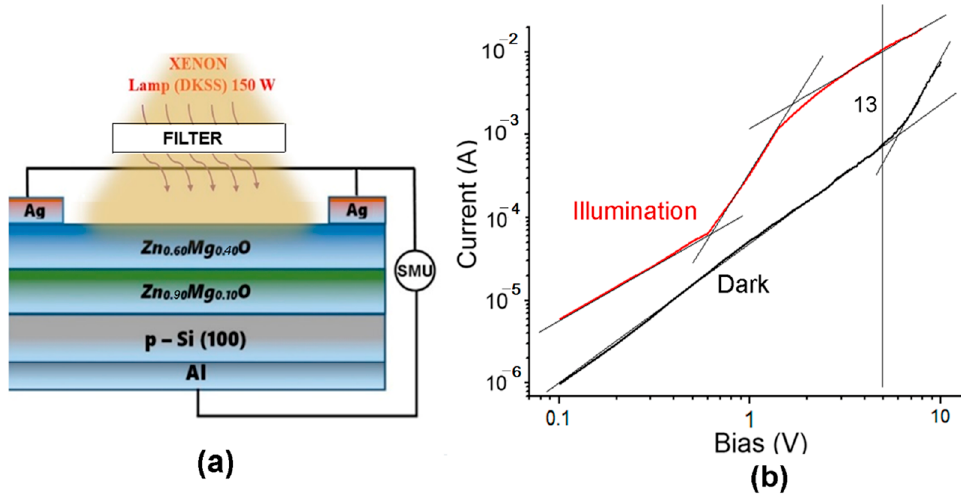
Figure 12. ( a ) Design of an Al/p-Si/n-Zn 90 Mg 10 O/n-Zn 60 Mg 40 O/Ag photodiode. ( b ) Current–voltage characteristics of the device fabricated on films deposited by spin coating plotted for the forward bias in a double logarithmic scale.